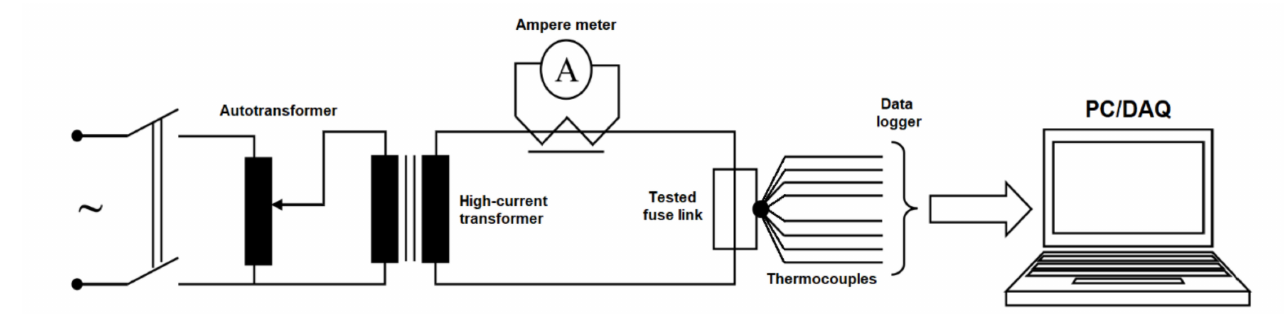
Figure 2. Diagram of the measuring system constructed for fuse link